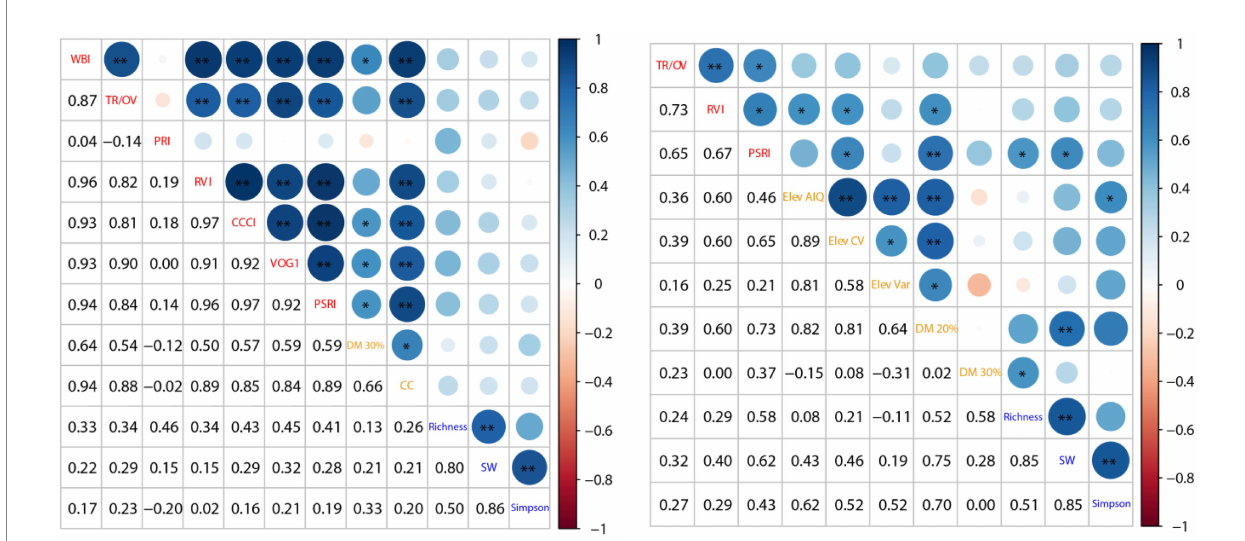
FIGURE 6 Selected features of two study areas (left: MZL, right: GGS; red labels: optimal biochemical VIs, orange labels: optimal structural features, blue labels: species diversity indices; TR/OV: TCARI/OSAVI, SW: Shannon-Wiener